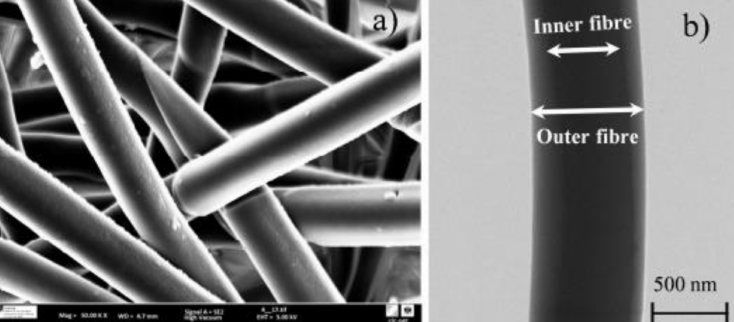
Figure 13. Pictures of ( a ) SEM; and ( b ) TEM of the multifunctionalised coaxial membrane, fabricated using PMMA as inner fiber and PdTFPP PolymBlend as outer fiber, reproduced with permission from